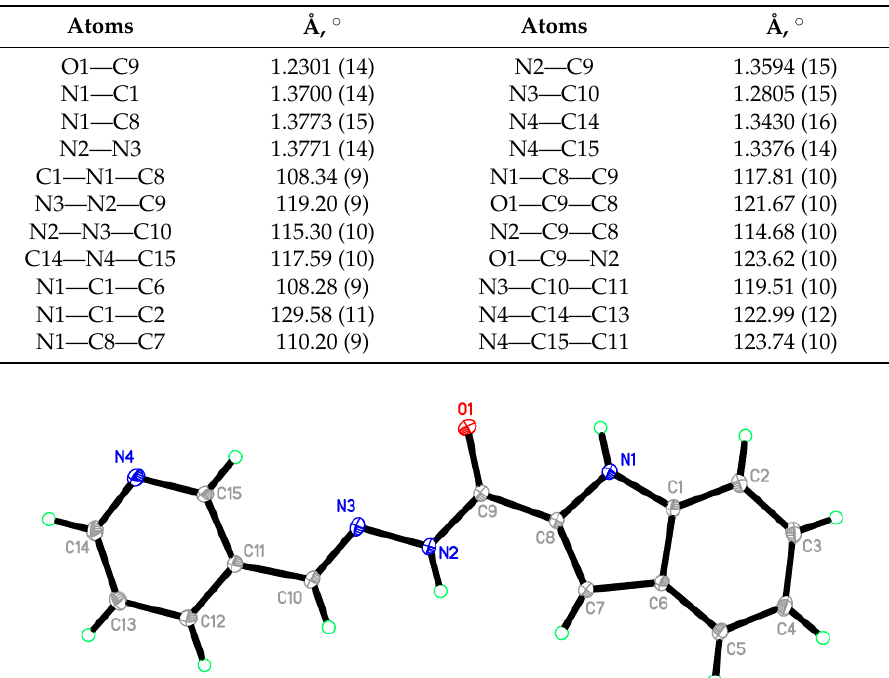
Molecules 2016 , 21 , 333 Table 4. Hydrogen-bond geometry (Å, °) in compound 13 . Table 4. Hydrogen-bond geometry (Å, °) in compound 13 .